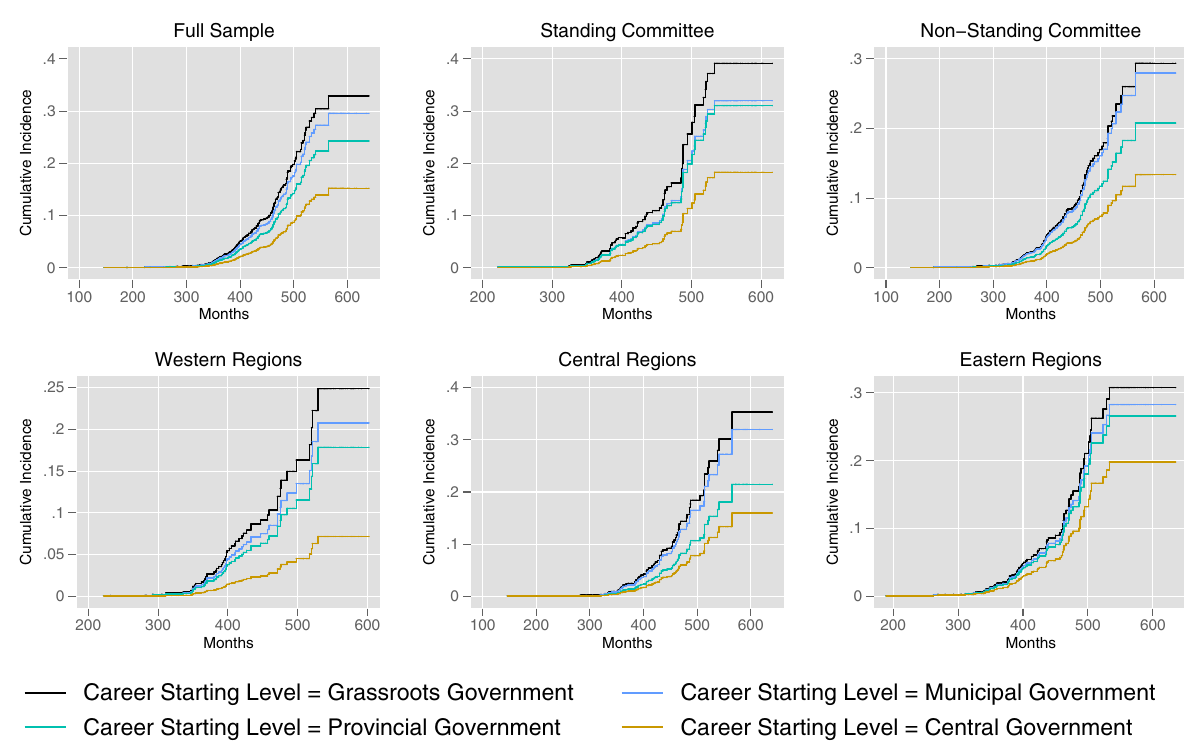
Fig. 3 The cumulative incidence curves of risk of political falling. The cumulative incidence curves of political falling from the highest to the lowest are grassroots government beginnings, municipal government beginnings, provincial government beginnings, and central government beginnings, which indicates that deputy mayors with higher career starting levels have lower cumulative rate of political falling. Thus, deputy mayors who started in the grassroots-level governments always had the highest cumulative political falling